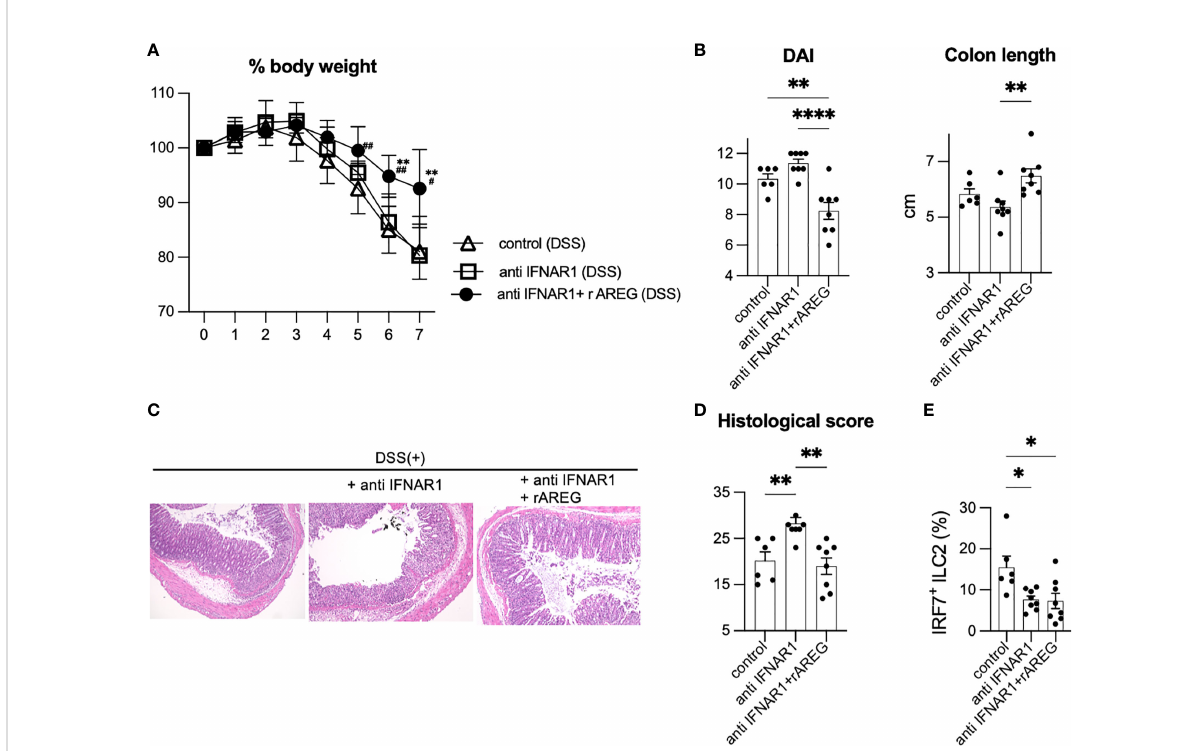
FIGURE 4 Amphiregulin treatment partially rescued severity of DSS-induced colitis in anti-IFNAR treated mice. WT mice were injected exogenous recombinant AREG (rAREG) over the course of DSS exposure with anti-IFNAR1 i.p. injection. Data are representative of two independent experiments (n=6 for control group, n=8 for anti IFNAR1 only and anti IFNAR1 plus rAREG injected group). (A) Change in % body weight relative to initial body weight of control mice (DSS treated) (n=6), anti IFNAR1 i.p. injected mice (DSS treated) (n=8) and anti IFNAR1 plus rAREG i.p. injected mice (DSS treated) (n=8). ** P <0.01 vs anti IFNAR1 group, # P <0.05, ## P <0.01 vs control group. (B) Disease activity index (DAI) score on day 7 and colon length of mice of each group. (C, D) Histological score and histopathology of distal colon. (E) Frequency of IRF7 + ILC2s in each group. Data are mean and SEM. * P < 0.05, ** P < 0.01, **** P <